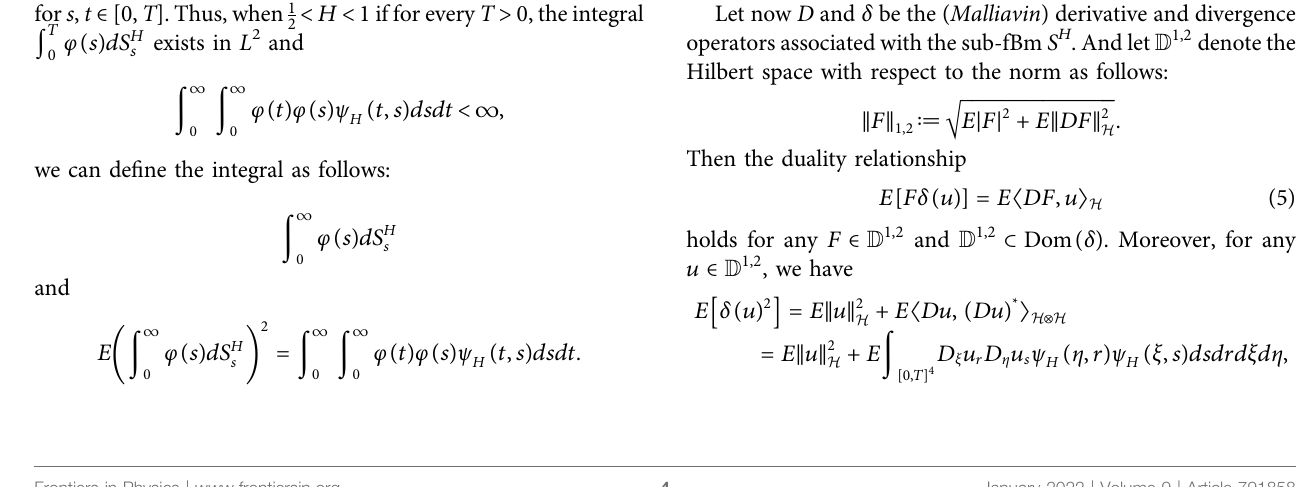
Frontiers in Physics |